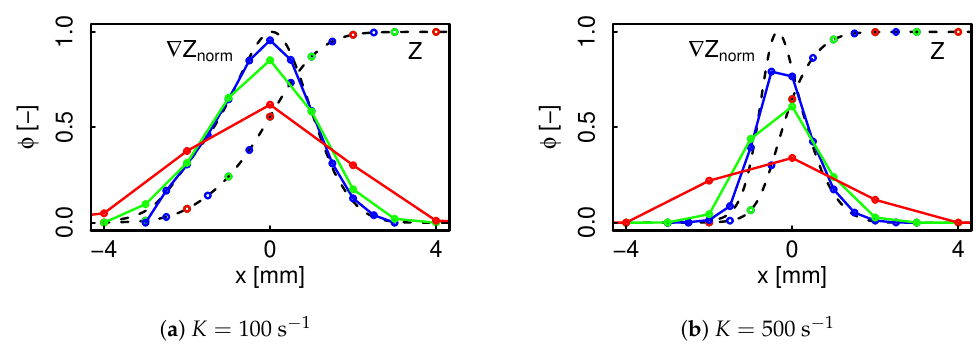
Figure 5. Numerical grid resolution effect over the mixture fraction gradient for two CH 4 - Air flamelets with ∆ = 2 mm. Blue line ∆ / ∆ x = 4, green line ∆ / ∆ x = 2, red line ∆ / ∆ x = 1, dashed lines are the reference filtered